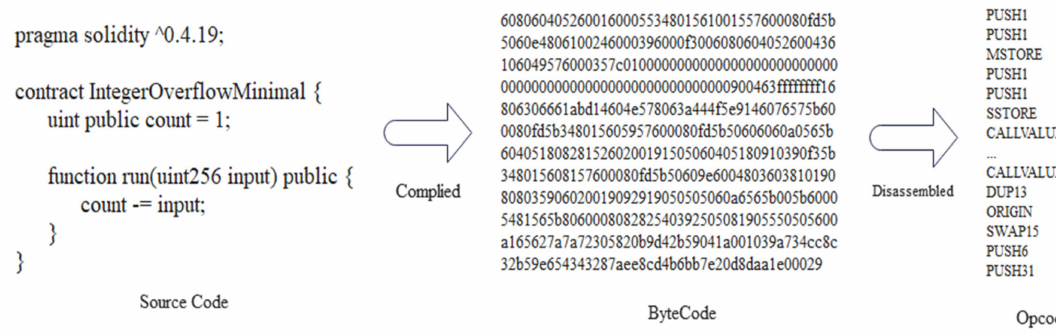
Figure 6. Opcode extraction